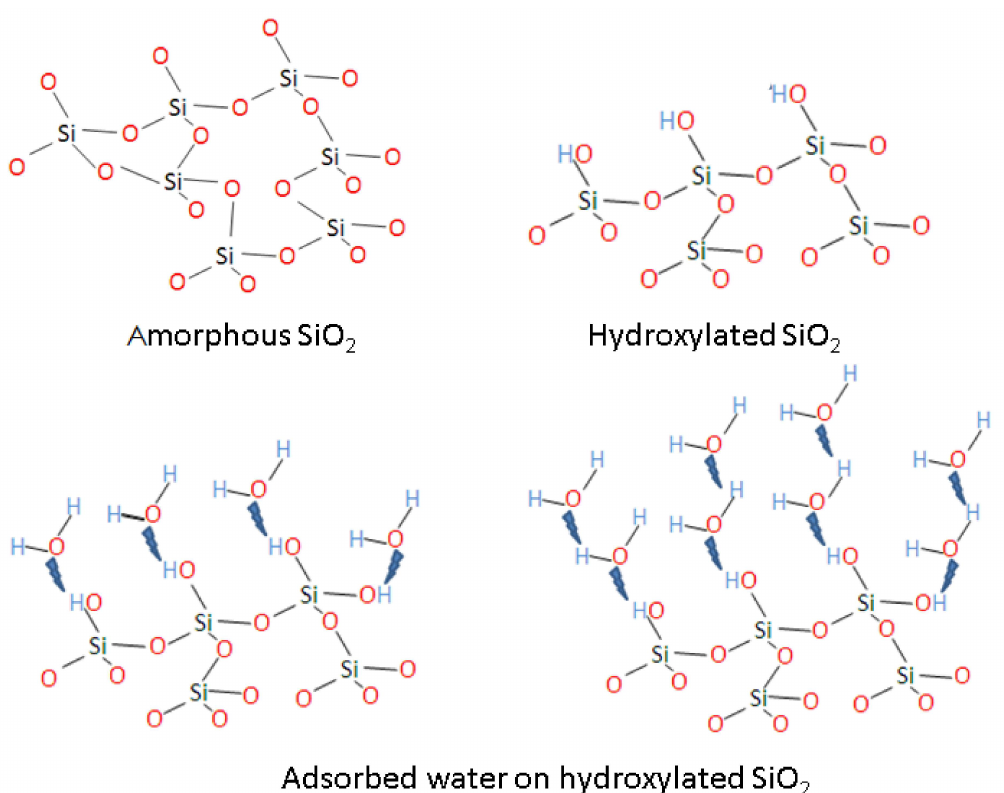
Figure 6. Schematic diagram illustrating stepwise OH − interactions with a-silica. Hydrogen bonding between absorbed water molecules is not shown in the figure, as it is beyond the scope of our